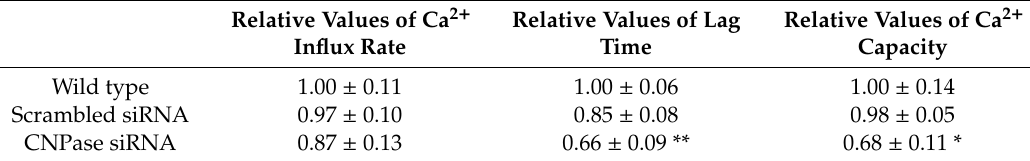
Table 1. Influence of CNPase knock-down on mitochondrial functional parameters at Ca 2 + -induced mPTP